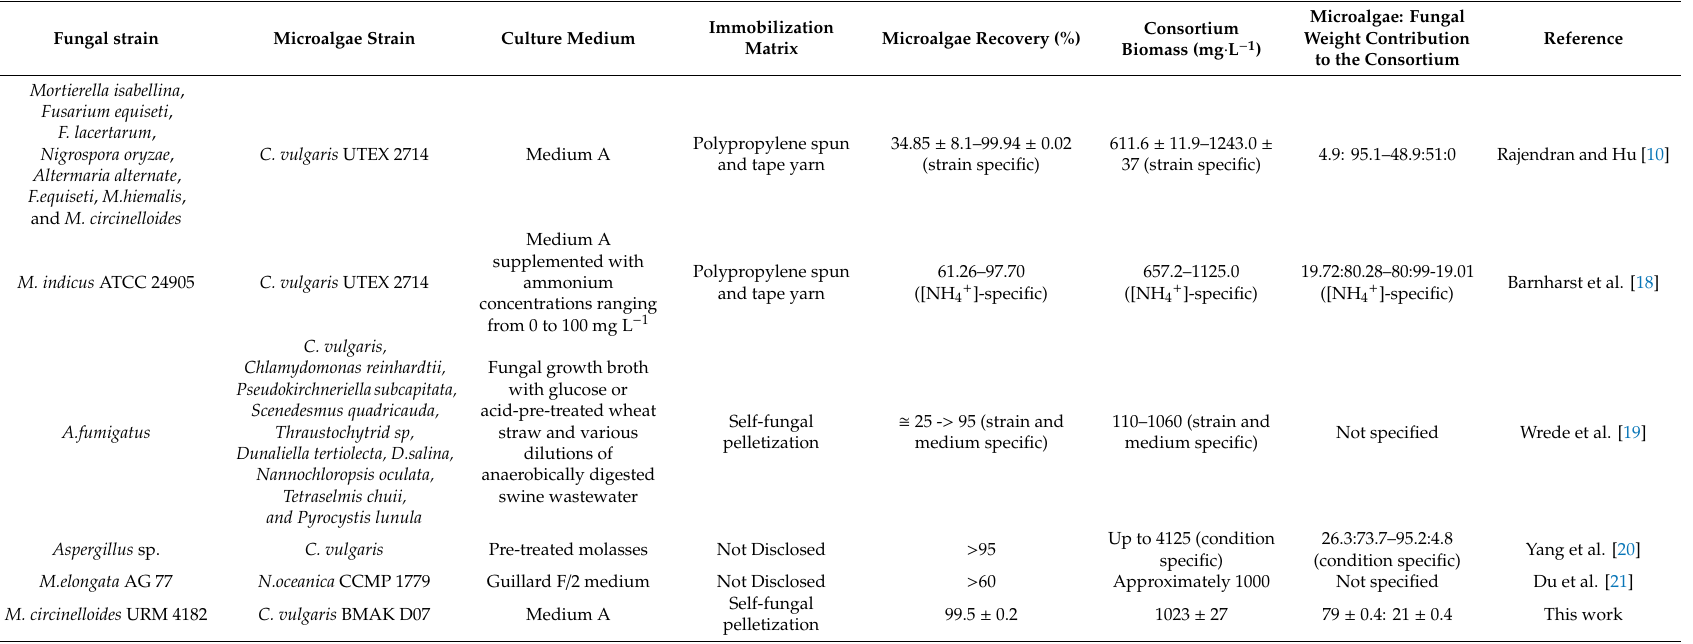
Table 3. Comparison of microalgal cell recovery, consortium biomass and weight distribution with literature